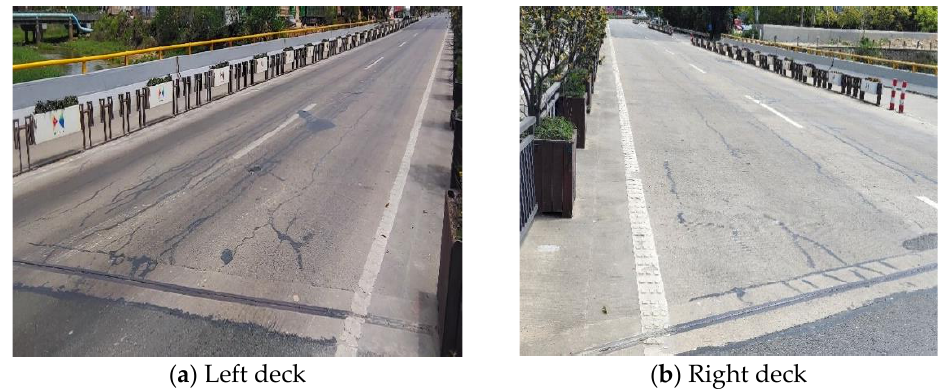
Figure 2. Status of the pavement of the bridge.